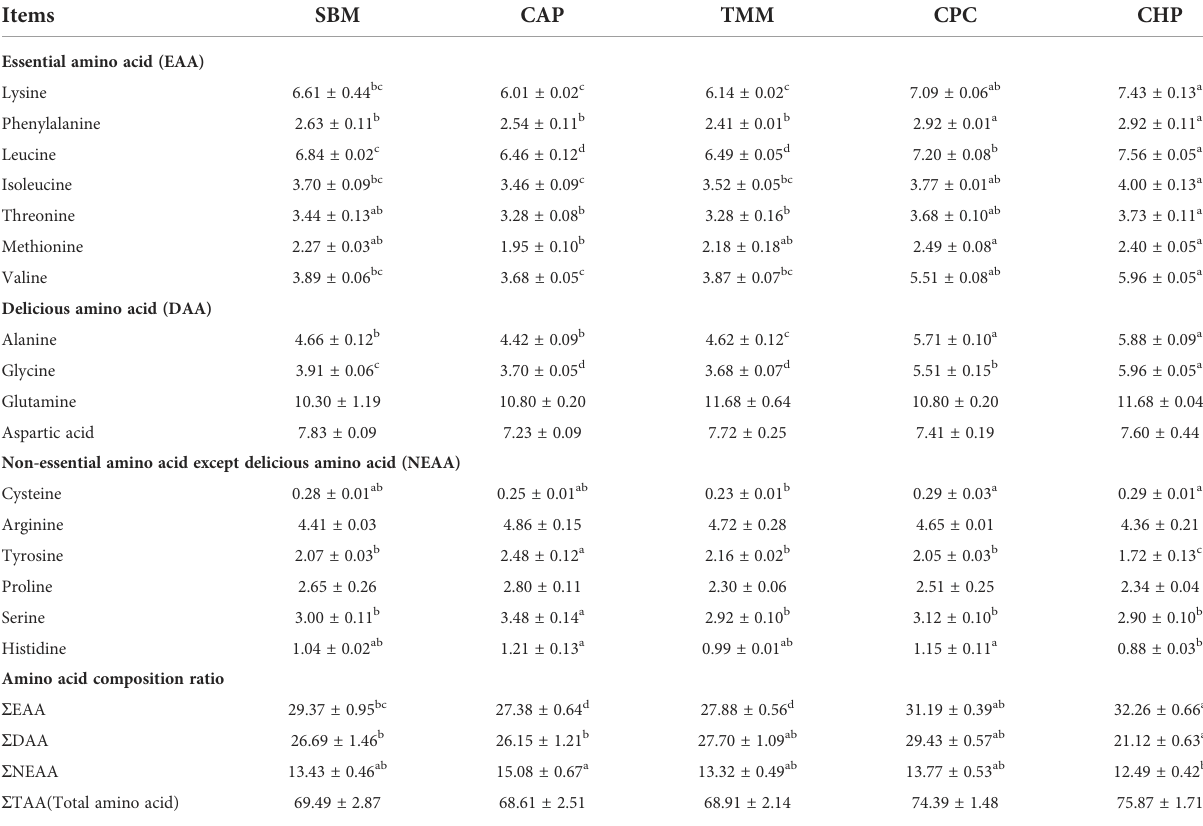
TABLE 8 Amino acid composition of grass carp muscle in large specimens (% dry-matter